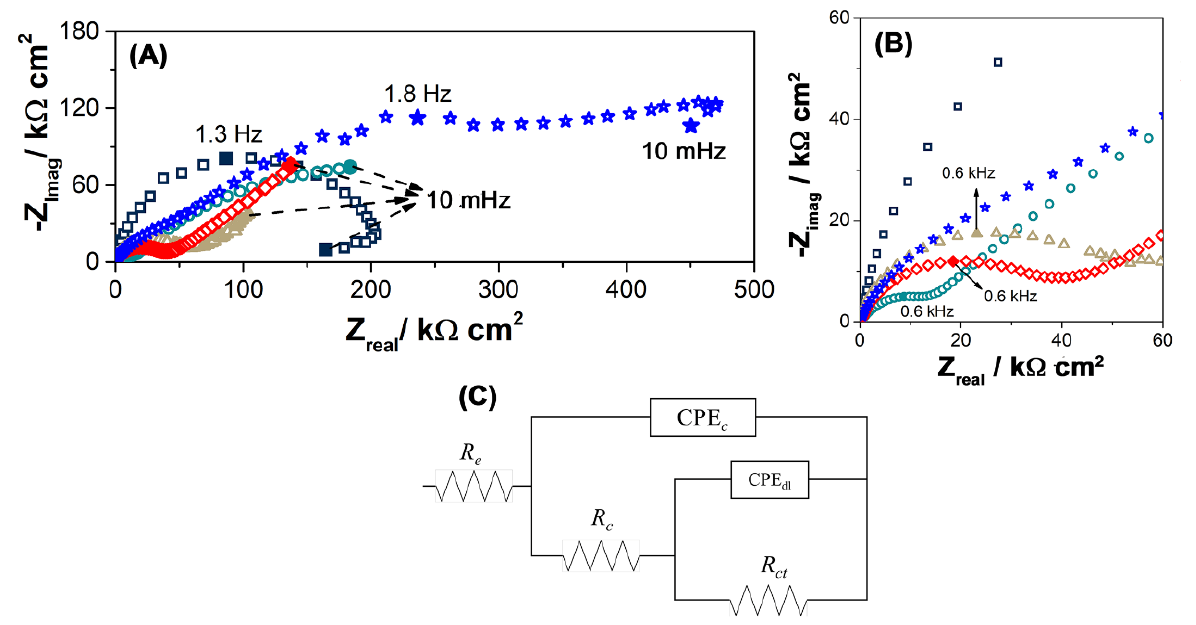
Figure 12. Impedance response of copper samples at different exposure times to the environment, measured in 0.1 M Na 2 SO 4 solution at E = OCP. ( A ) Nyquist plot and ( B ) zoom of Nyquist plot. Exposure at 0 months (□), 3 months ( ○ ), 12 months ( △ ), 24 months ( ◇ ), and 36 months ( ☆ ). ( C ) Equivalent circuit models.